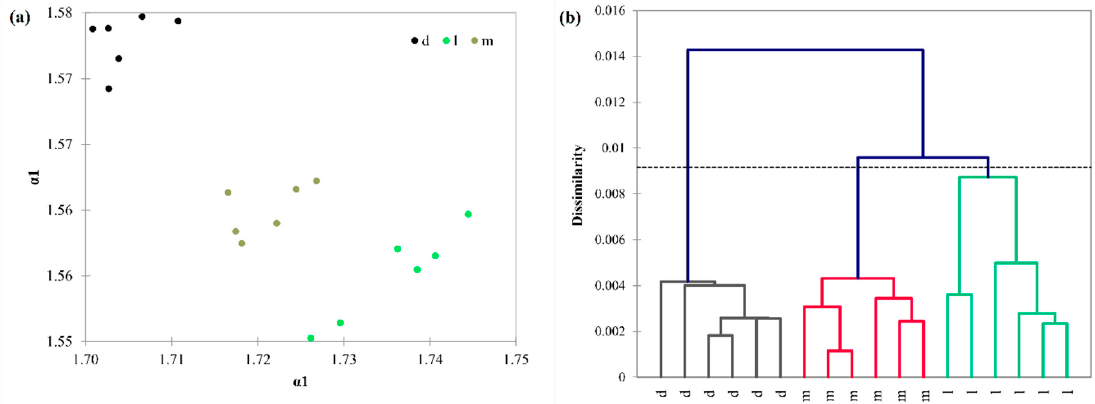
Figure 6. Detrended fluctuation analysis of the parallel measurements of the Columbian co ff ee samples. ( a ) α 1 and α 2 coe ffi cients obtained from detrended fluctuation analysis. Spectra of the light (l), medium (m) and dark (d) roast samples are coded by di ff erent colors. ( b ) Agglomerative hierarchical cluster analysis of the α 1 and α 2 coe ffi cients using Euclidean distance and complete linkage.